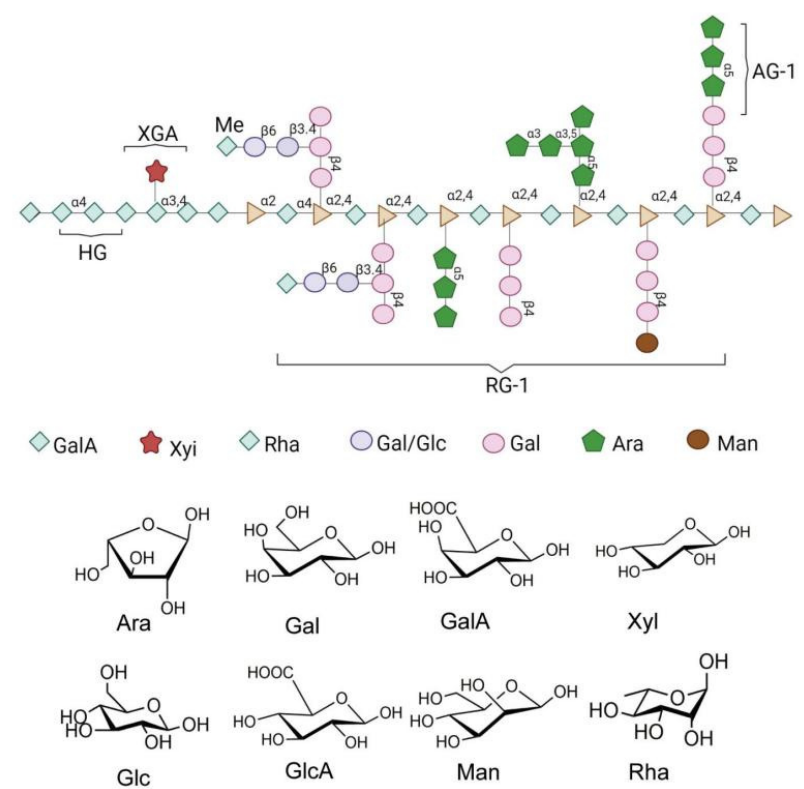
Figure 1. Chemical and structural formula of the Cyclocarya paliurus polysaccharide. Table 1. The mechanism of action of the different Cyclocarya paliurus extracts on type 2 diabetes mellitus.